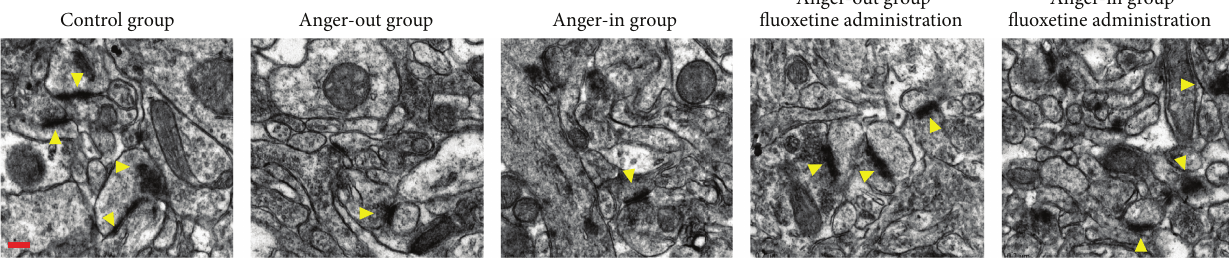
Figure 3: Synaptic ultrastructure in hippocampal CA3 of control, anger-out, anger-in, fluoxetine treated anger-out, and fluoxetine treated anger-in groups. Arrow heads were used to highlight synapses. Scale bar: 0.2 𝜇 m.